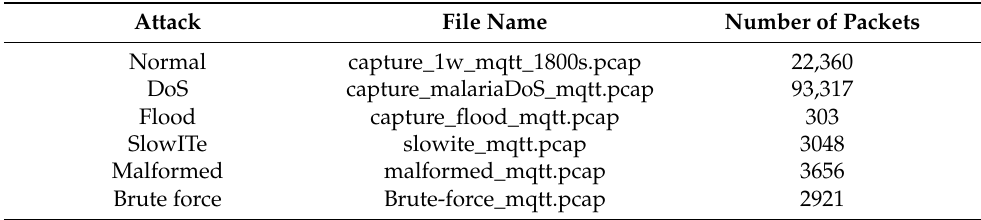
Table 3. MQTT pcap Table 3. MQTT pcap files.